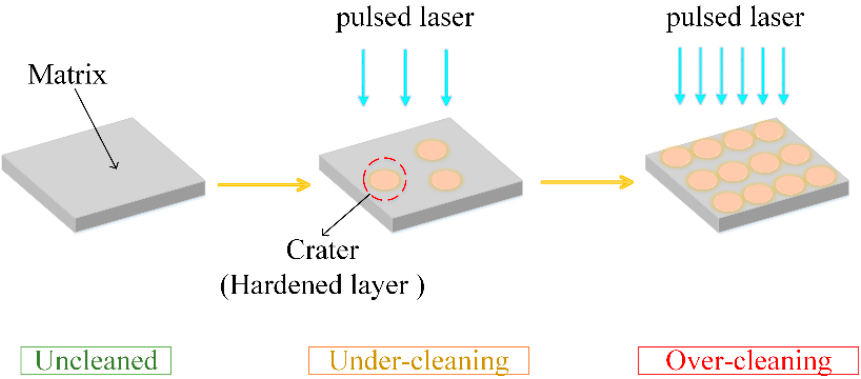
Coatings 2022 , 12 , x FOR PEER REVIEW Figure 7. ( a ) Vickers microhardness of each sample under different loading energy densities; ( b ) residual stress of each sample under different loading energy densities.